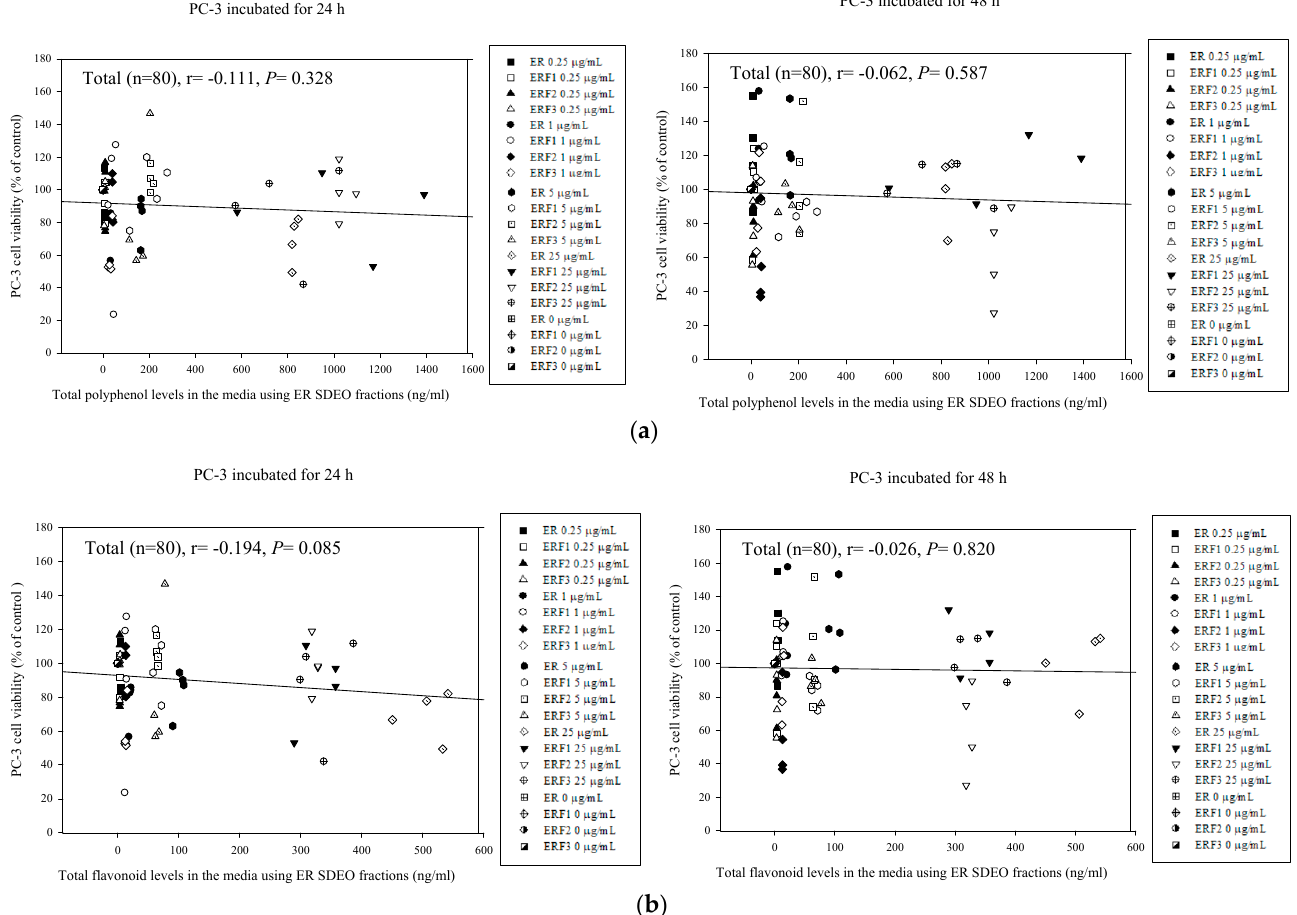
Figure 8. The associations between IL-2 ( a ), IL-10 ( b ), as well as IL-10/IL-2 cytokine secretion ratios ( c ) in SCM and their corresponding PC-3 cell viabilities treated with SCM for 24 and 48 h, respectively. The correlation was expressed by Pear- son product–moment correlation coefficient (r). * p < 0.05; ** p < 0.01.